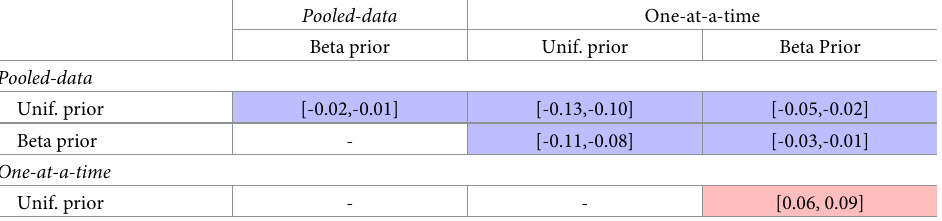
Table 5. Differences in Mean Absolute Error [MAE]. Each cell shows the 95% confidence interval for the difference in MAE resulting from MCMC estimates using different priors (row method minus column method). Cells are color coded blue when the method on that row has a significantly smaller MAE than the method on that column; Conversely, cells are colored red when the method in that column outperforms the method in that row. Overall, predictions calcu- lated using the parameter estimates from pooled-data predictions outperform one-at-a-time